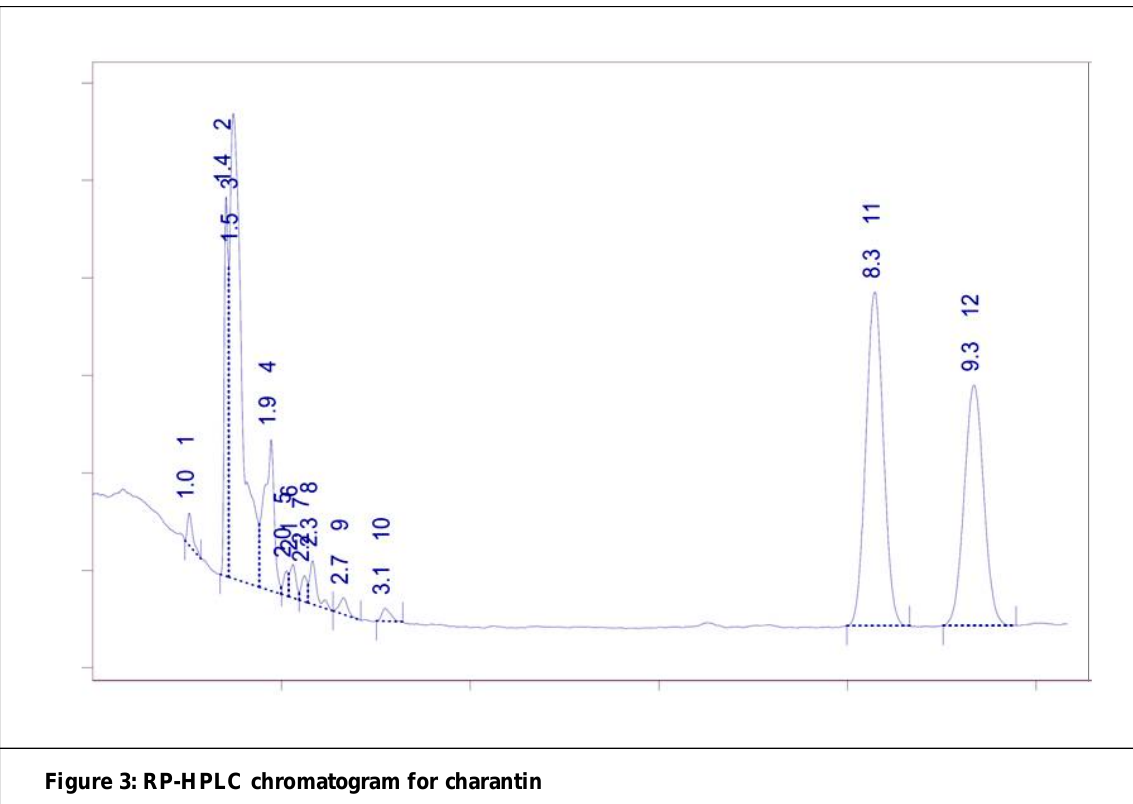
areaFigure 3: RP-HPLC chromatogram for